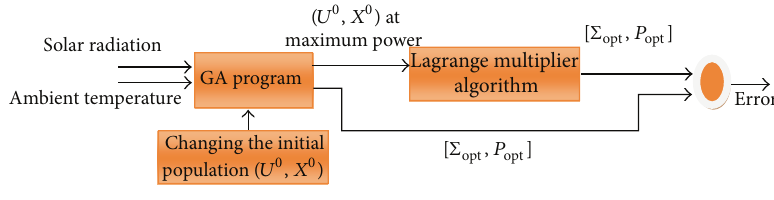
Figure 7: The proposed analysis steps.